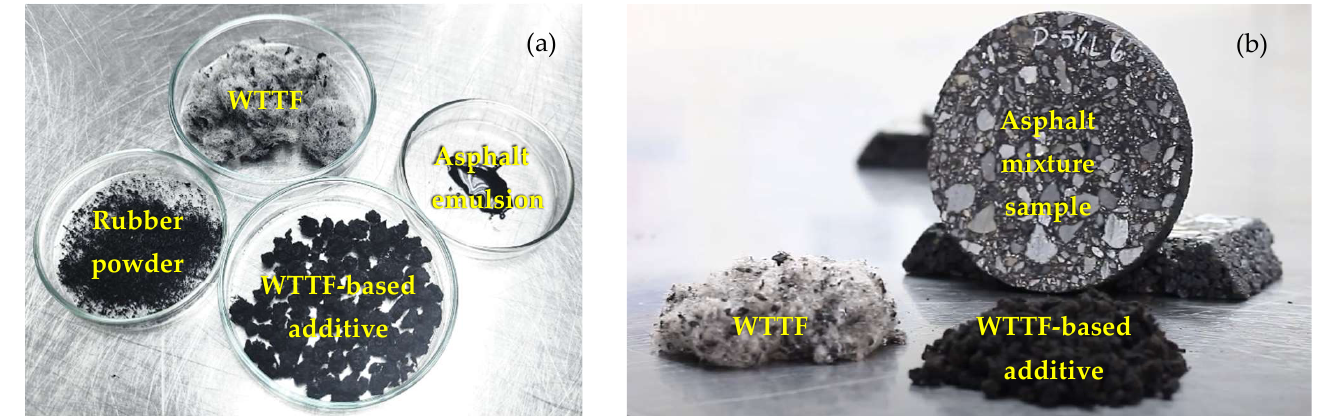
Figure 3. Images of the WTTF-based additive with its components ( a ) and its application on a sample ( b ).